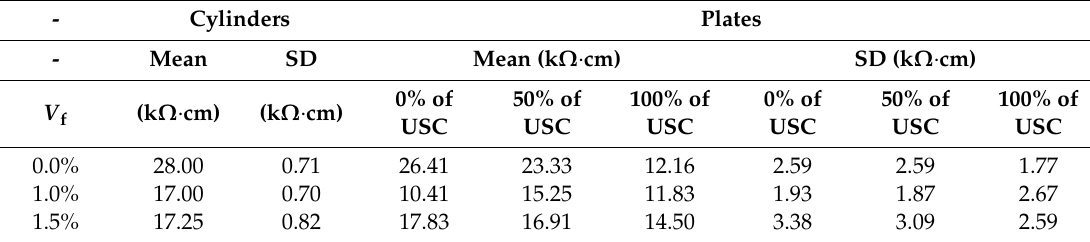
Figure 5. Surface resistivity of standard cylinders and plates with di ff erent amount of fibre ( V f ) and values of load (USC). Table 3. Results of surface resistivity of structural lightweight waste aggregate concrete